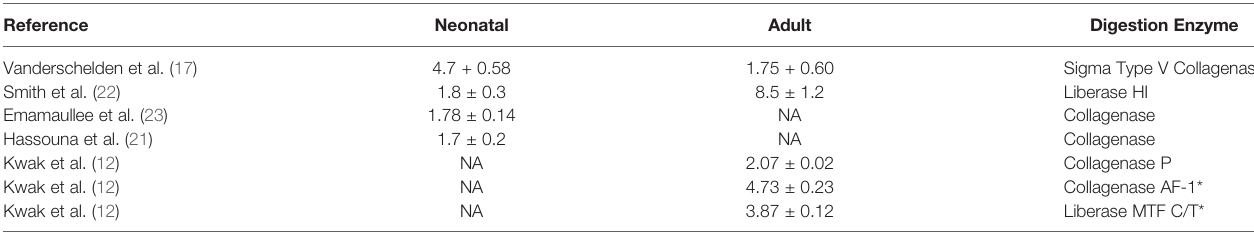
TABLE 2 | In vitro stimulation index of neonatal and adult pig